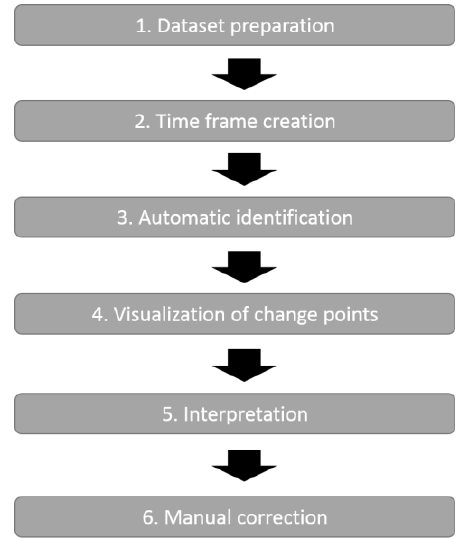
Figure 1. Overall flow of MATCHED method